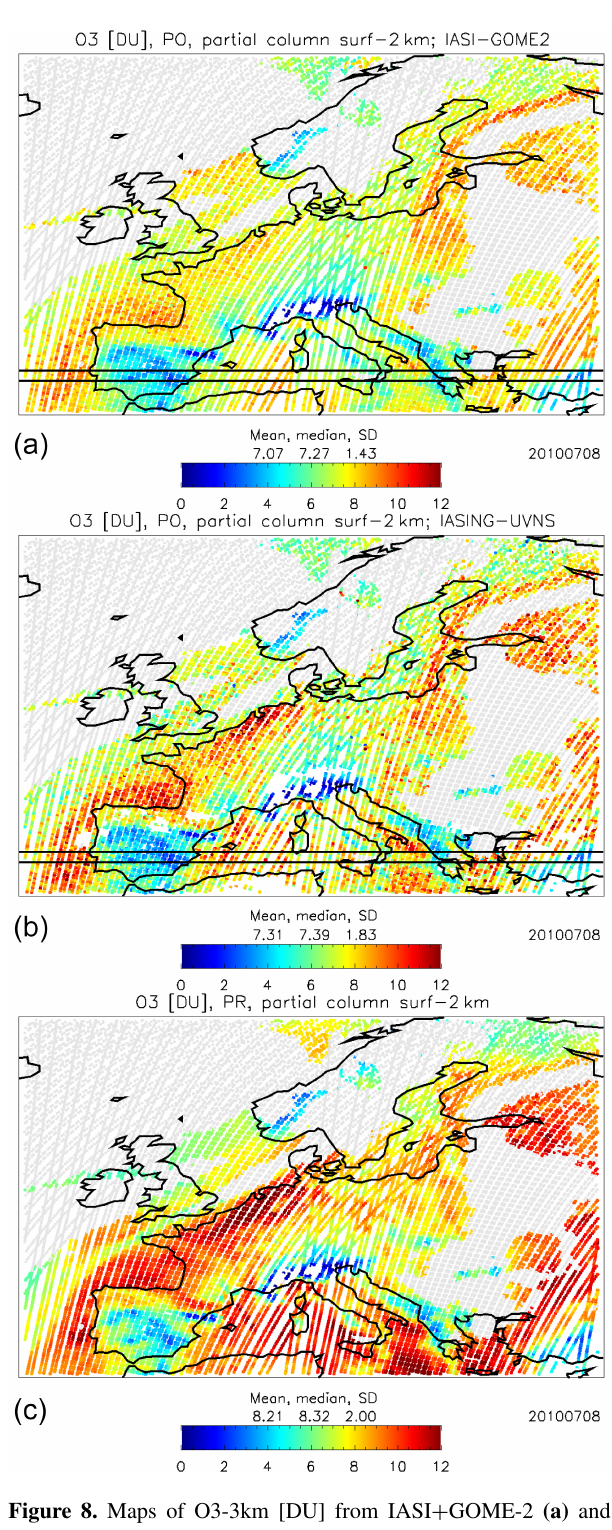
Figure 8. Maps of O3-3km [DU] from IASI + GOME-2 (a) and IASI-NG + UVNS (b) pseudo-observations and PR (c) for 8 July